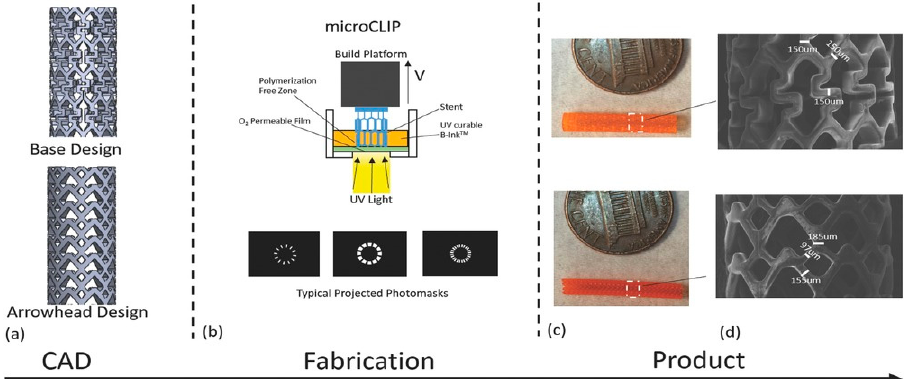
Figure 3. SLA processing of vascular stents. ( a ) CAD images of the initial/primary design (Base Design) and a secondary design (Arrowhead Design). ( b ) Diagram of continuous liquid interface production microstereolithography (microCLIP) with typical projected photomasks of the stent. ( c ) 3D-printed base design ( top ) and arrowhead design ( bottom ) stents. ( d ) Scanning electron mi- croscopy images of the base design ( top ) and arrowhead design ( bottom ) [59], Copyright © 1999–2022 John Wiley & Sons, Inc.